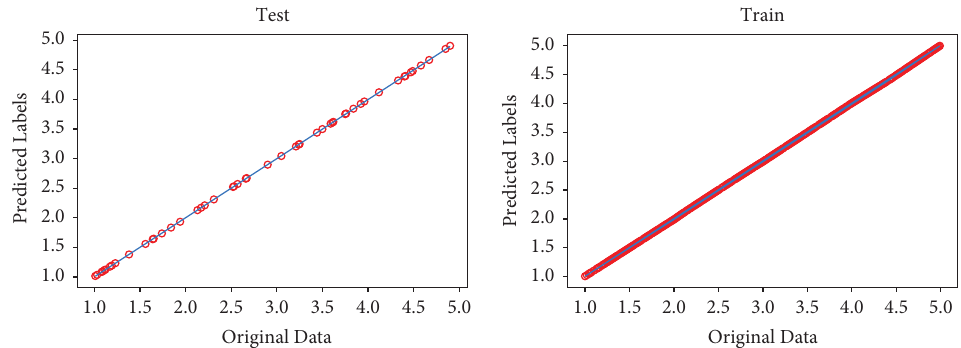
Figure 9: Dispersion of test data (a) and training (b) in the amount predicted in the proposed method.